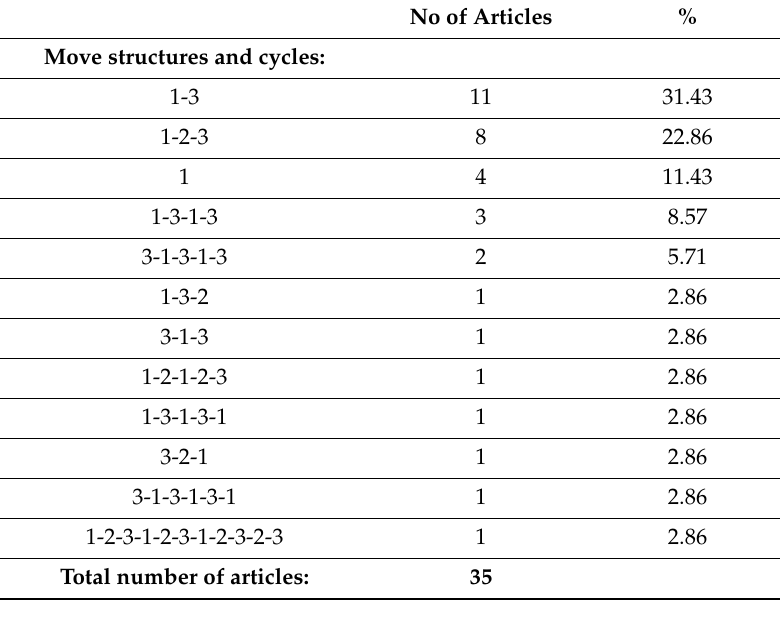
Table A9. SID 1994.